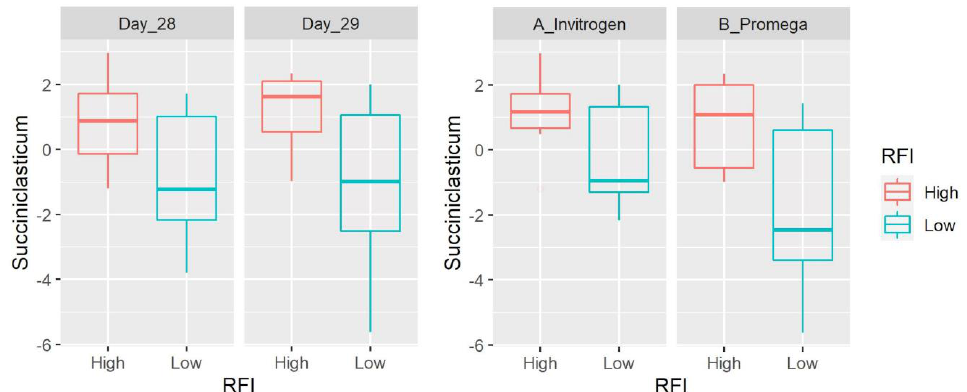
Figure 1. Box plots showing the abundance of Succiniclasticum (Firmicutes) based on clr-transformed data. Data are shown for both day of sampling and DNA extraction method. There was a significant difference between LRFI and HRFI ( p = 0.0011), with no time or DNA extraction effect.